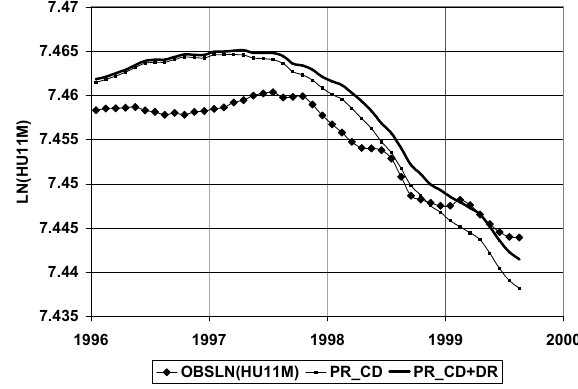
Fig.7. Fig. 7. The same as in Fig. 6, but for Huancayo/Haleakala NM. NM (effective rigidity of primary particles 10–15 GV) and A dr ≈ 0.25% for Huancayo/Haleakala NM (35–45 GV). We came to the conclusion that for Climax NM (effective rigid- ity of primary particles 10–15 GV) the convection-diffusion mechanism gives about 80% of the observed modulation and a drift mechanism of about 20%; for Huancayo/Haleakala NM (effective rigidity of primary particles 35–45 GV) the relative role of drift effects is about 3 times smaller. By re- gression coefficients of Eq. (1), estimated for X o max ≈ 15 av. months and A dr ≈ 2% for Climax NM, and A dr ≈ 0.25% for Huancayo/Haleakala NM we determined the expected convection-diffusion modulation in 1996-1999 only on the basis of monthly sunspot numbers. By adding the expected drift effects, we determined the “predicted” CR intensity. Comparison with observed data gives correlation coefficients 0.988 and 0.986 for Climax NM and Huancayo/Haleakala NM, accordingly. If it is a good prediction of SA for about one solar cycle, correspondingly, then the prediction on the CR intensity variation can be made for about 10–12 years